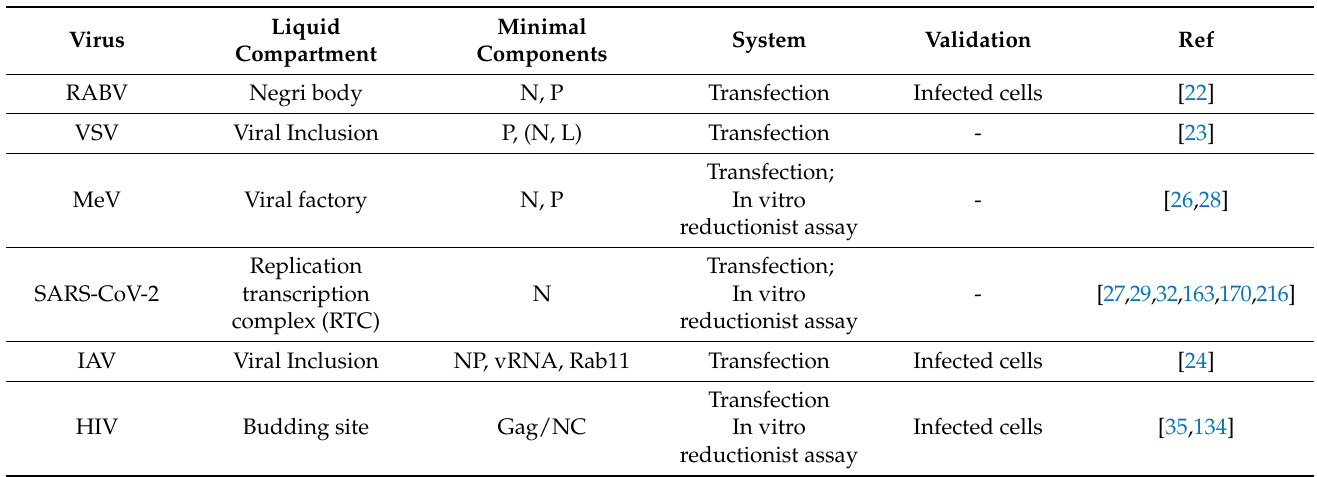
Table 1. Summary of the viruses shown to use liquid organelles and the proteins necessary to induce their formation.